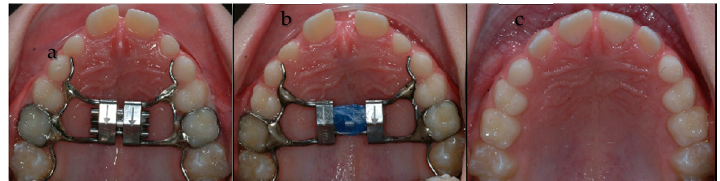
Figure 2. Control Group: rapid maxillary expander (RME) banded on primary second molars before ( a ), after activation ( b ) and to the removal ( c ). Table 1. Starting form comparison (T0 RME vs. T0 slow maxillary expander—SME).